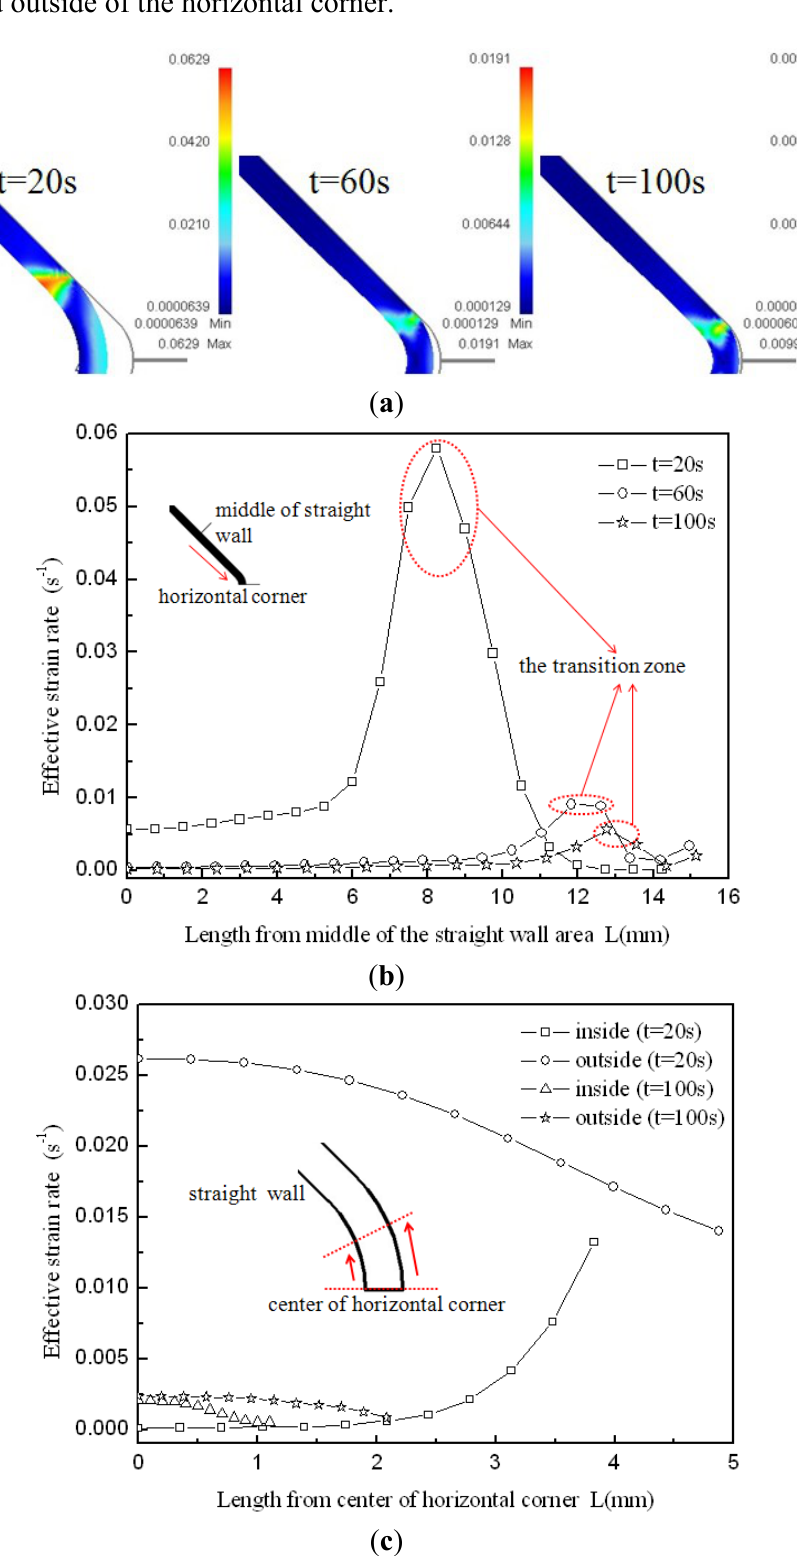
Figure 10. ( a ) Finite Element Method results of effective strain rate distribution; ( b ) values of effective strain rate at the inside of the component; ( c ) values of effective strain rate at the inside and outside of the horizontal corner.